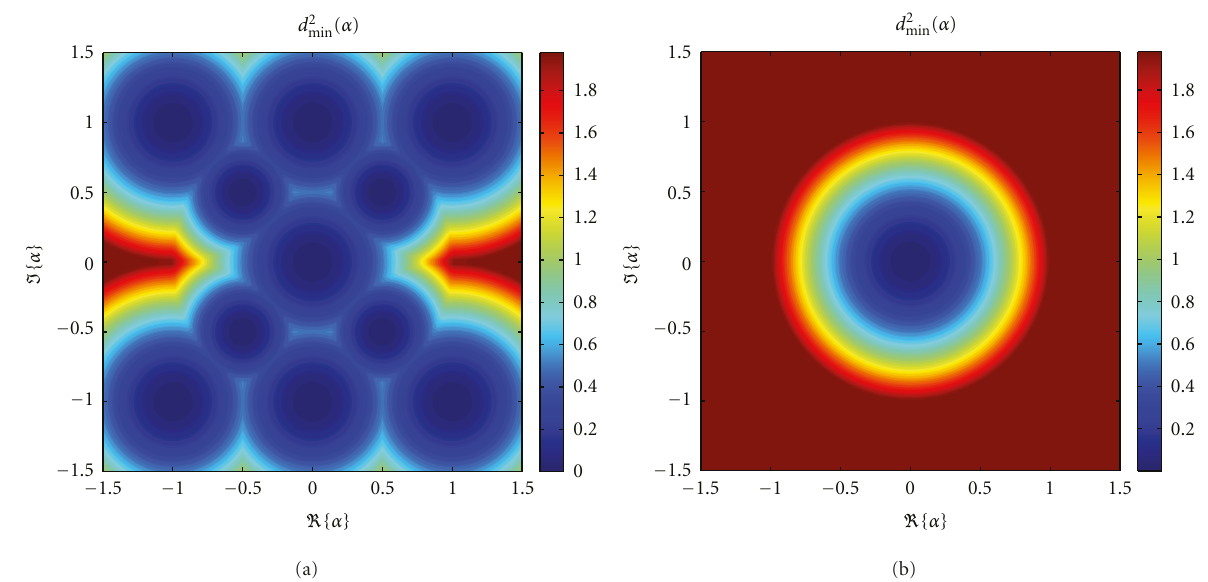
Figure 8: Hierarchical minimum distance performance for QPSK and 4-ary example codebook